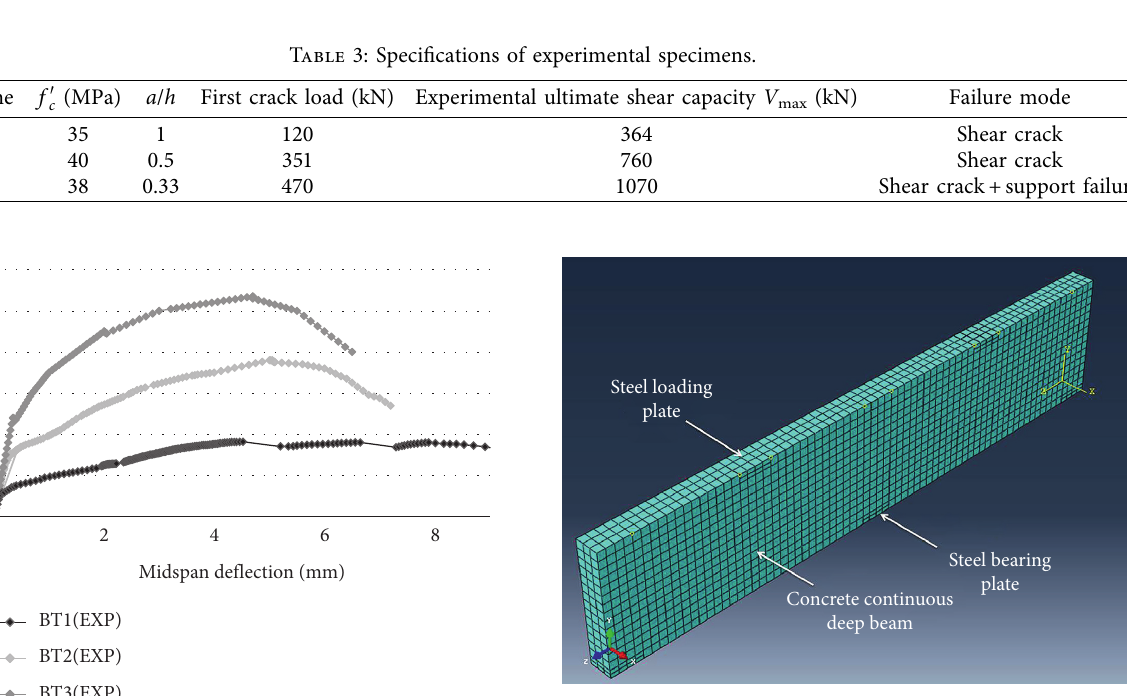
Figure 5: FE model and meshing of the continuous deep